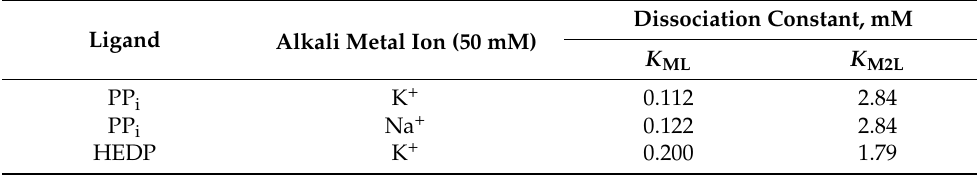
Table 3. The apparent dissociation constants for PP i and HEDP complexes with Mg 2+ at pH 7.2, 25 ◦ C, as calculated from the literature’s data [28,43]. K ML and K M2L refer to mono-magnesium and dimagnesium complexes of PP i or HEDP,